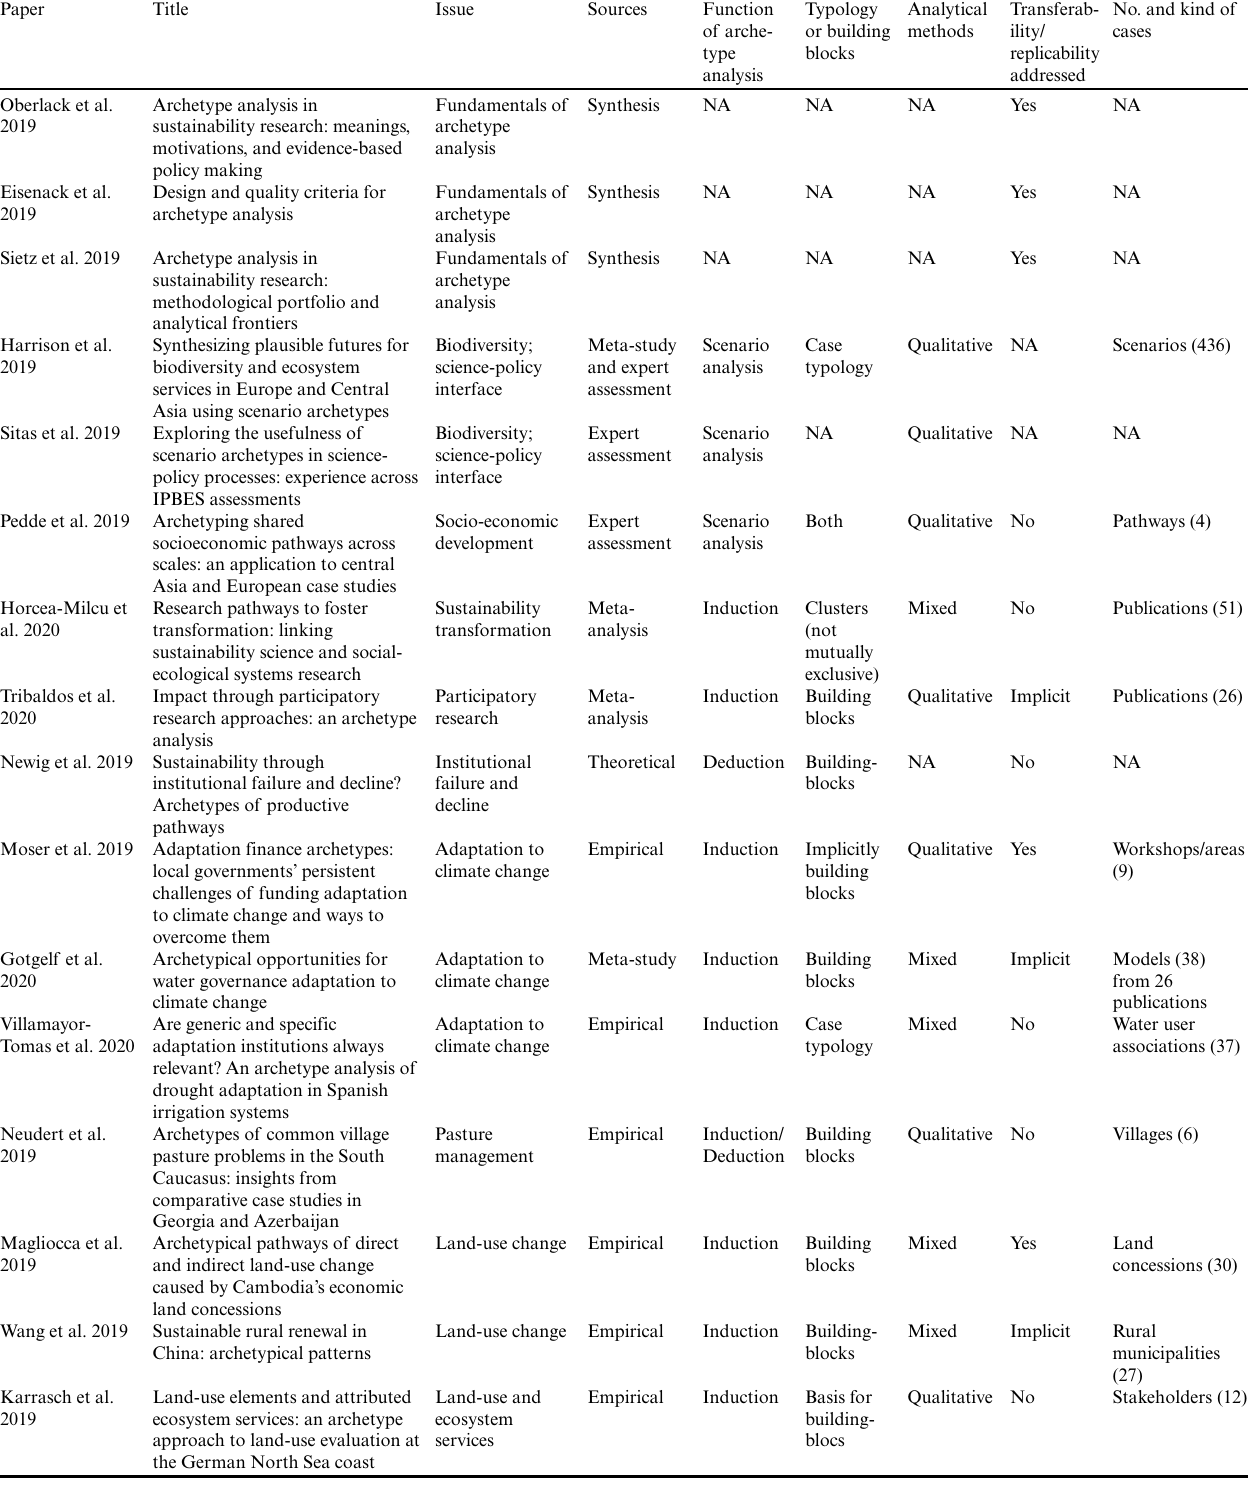
Table 2 . Summary of